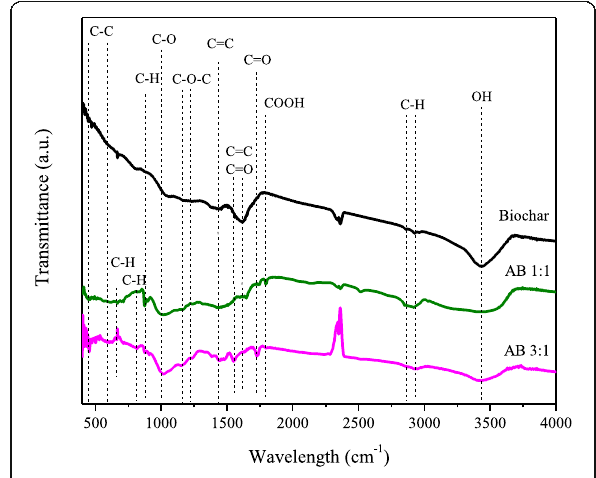
Fig. 8 FTIR spectra of activated